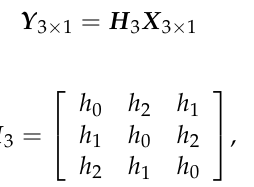
Figure 1. Algorithmic structure of the processing core for the computation of the 2-point circular